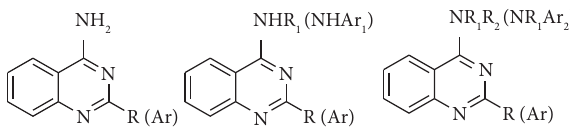
Figure 1: 4-aminoquinazoline